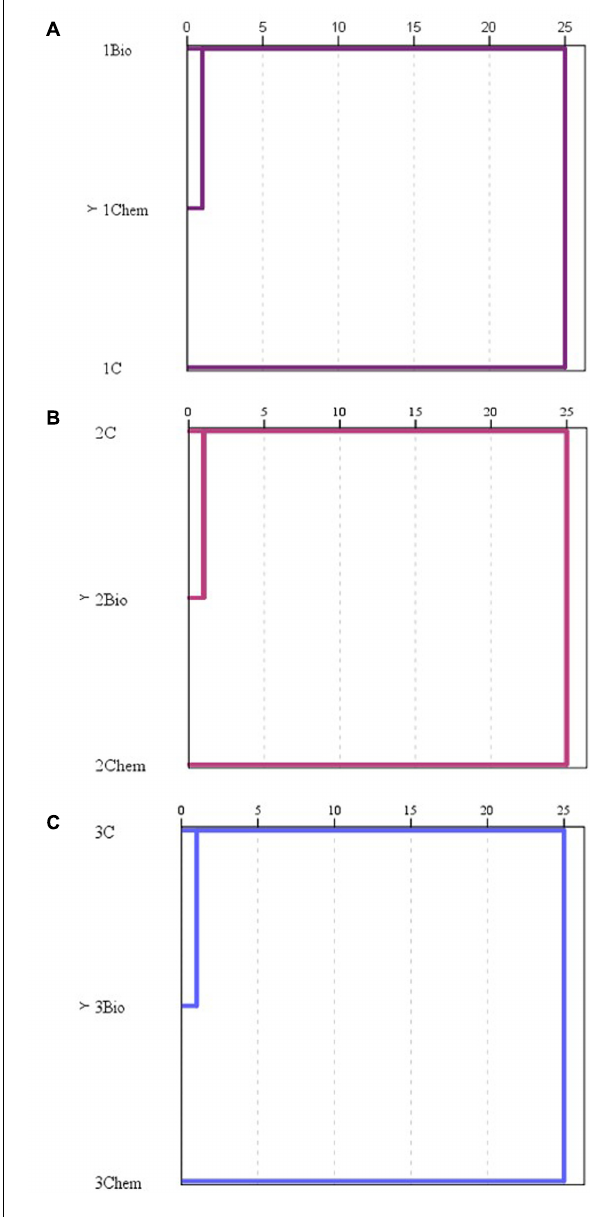
FIGURE 5 | Hierarchical cluster of the diversity indexes of the samples (C: control, Bio: bio-fungicide, and Chem: chemical fungicide) assessed for the grape biofilm (A) , for the must (B) , and for the wine stage (C) .